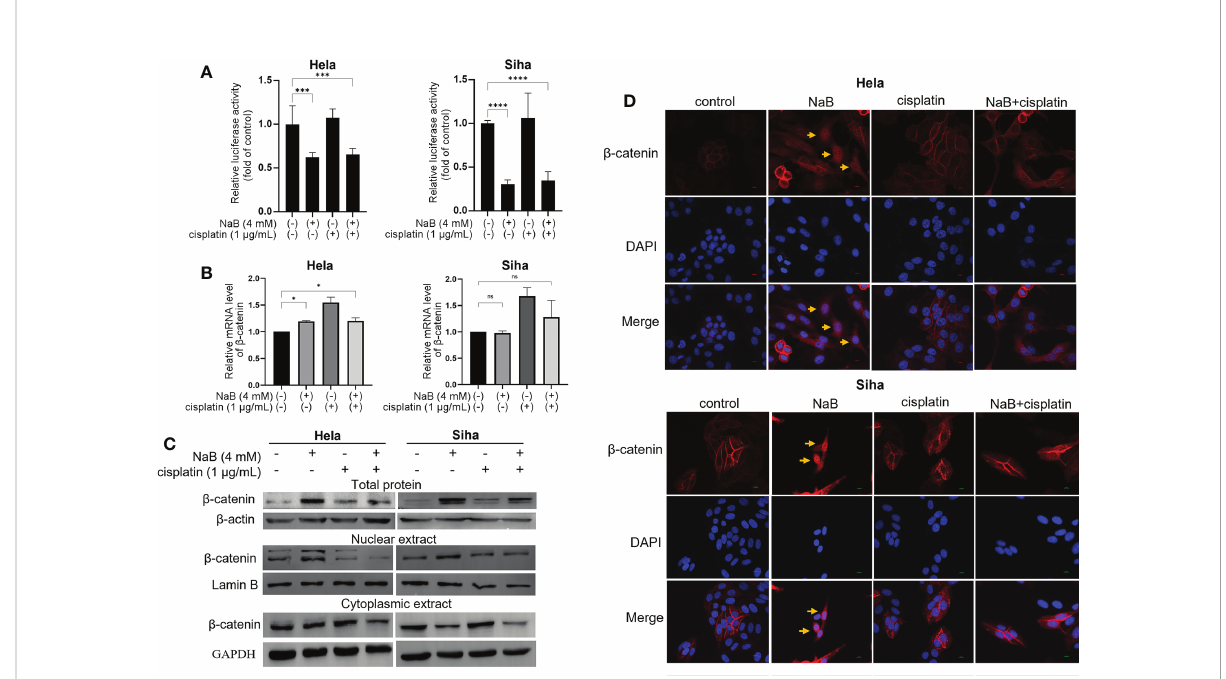
FIGURE 4 Effects of NaB in combination with cisplatin on Wnt/ b -catenin signaling. (A) The luciferase activity in Hela and Siha cells was measured by luciferase reporter gene assay. (B) qRT-PCR was applied to detect the relative expression of b -catenin. (C) Protein bands of b -catenin from total protein, nuclear extract and cytoplasmic extract in Hela and Siha cells were visualized. (D) Immuno fl uorescence analysis of b -catenin (red) in Hela and Siha cells. Arrowhead (yellow) indicates the accumulation of b -catenin in the nuclear region. Hela and Siha cells were treated with NaB (4 mM) alone or in combination with cisplatin (1 m g/mL). Data represent the mean + standard deviation from 3 independent experiments. Signi fi cance was examined by one-way ANOVA ( ns P > 0.05, *P < 0.05, ***P < 0.001, ****P < 0.0001). NaB, sodium butyrate. Magni fi cation: 200